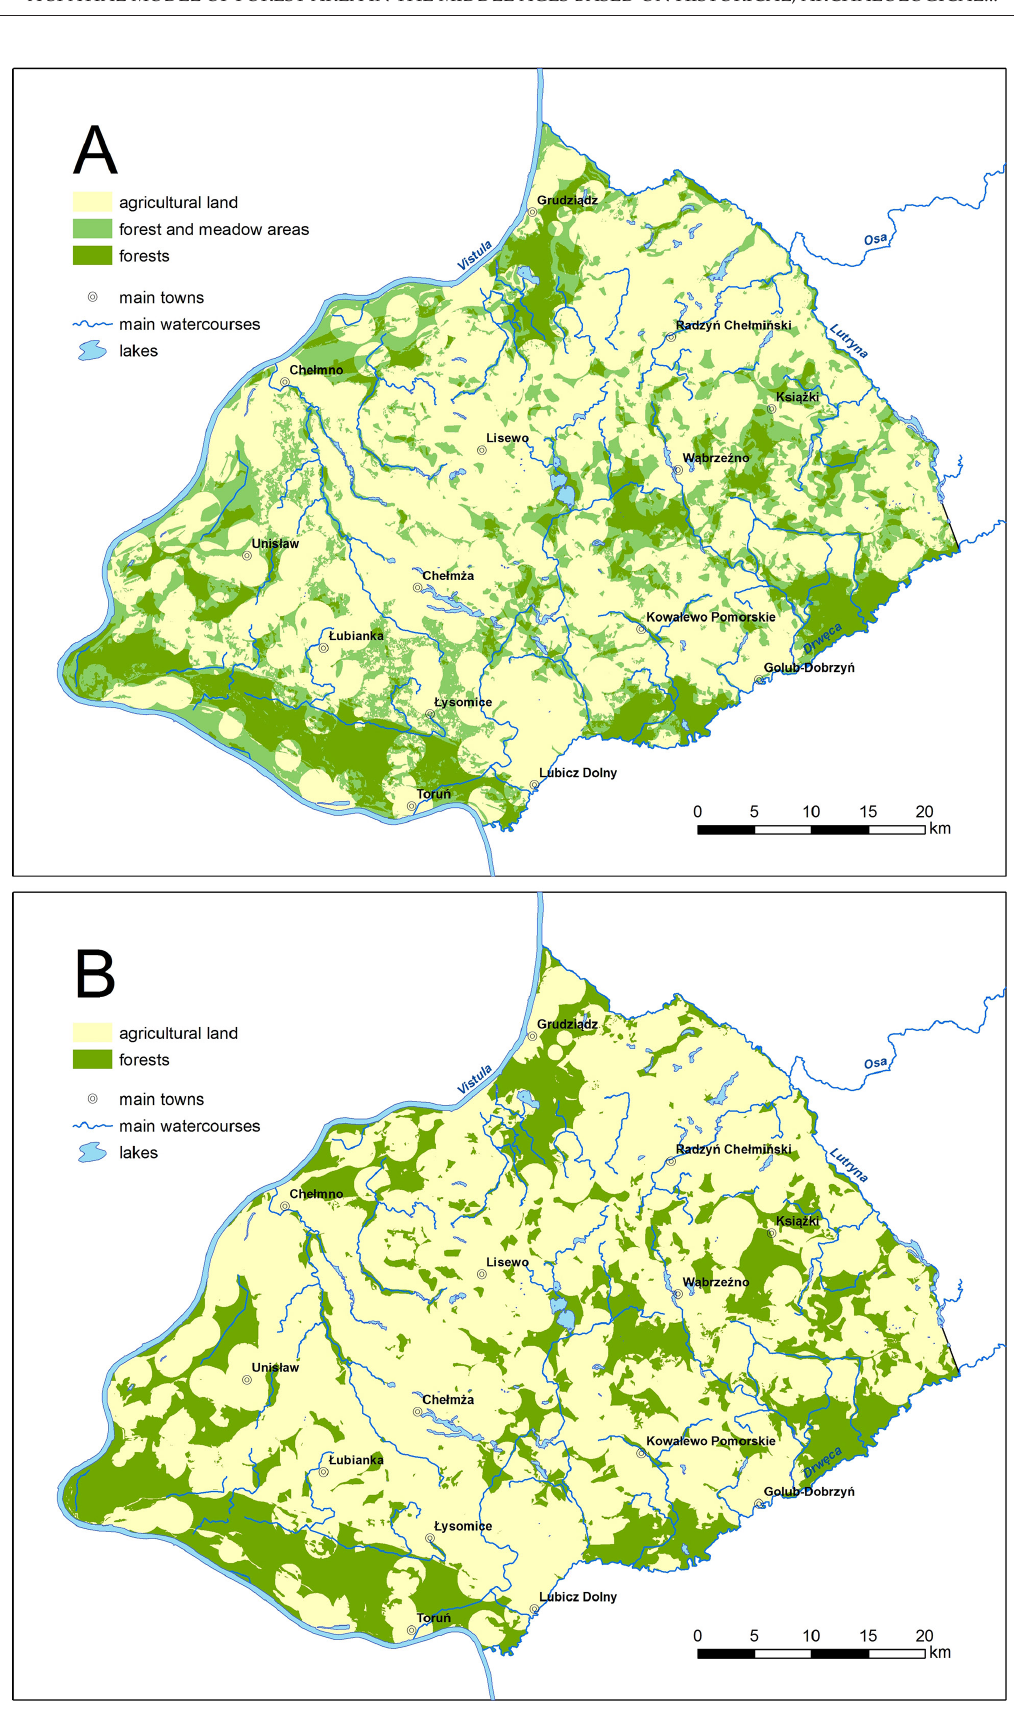
Fig. 12. Variants of the hypothetical forest area of Chełmno Land in the 13th